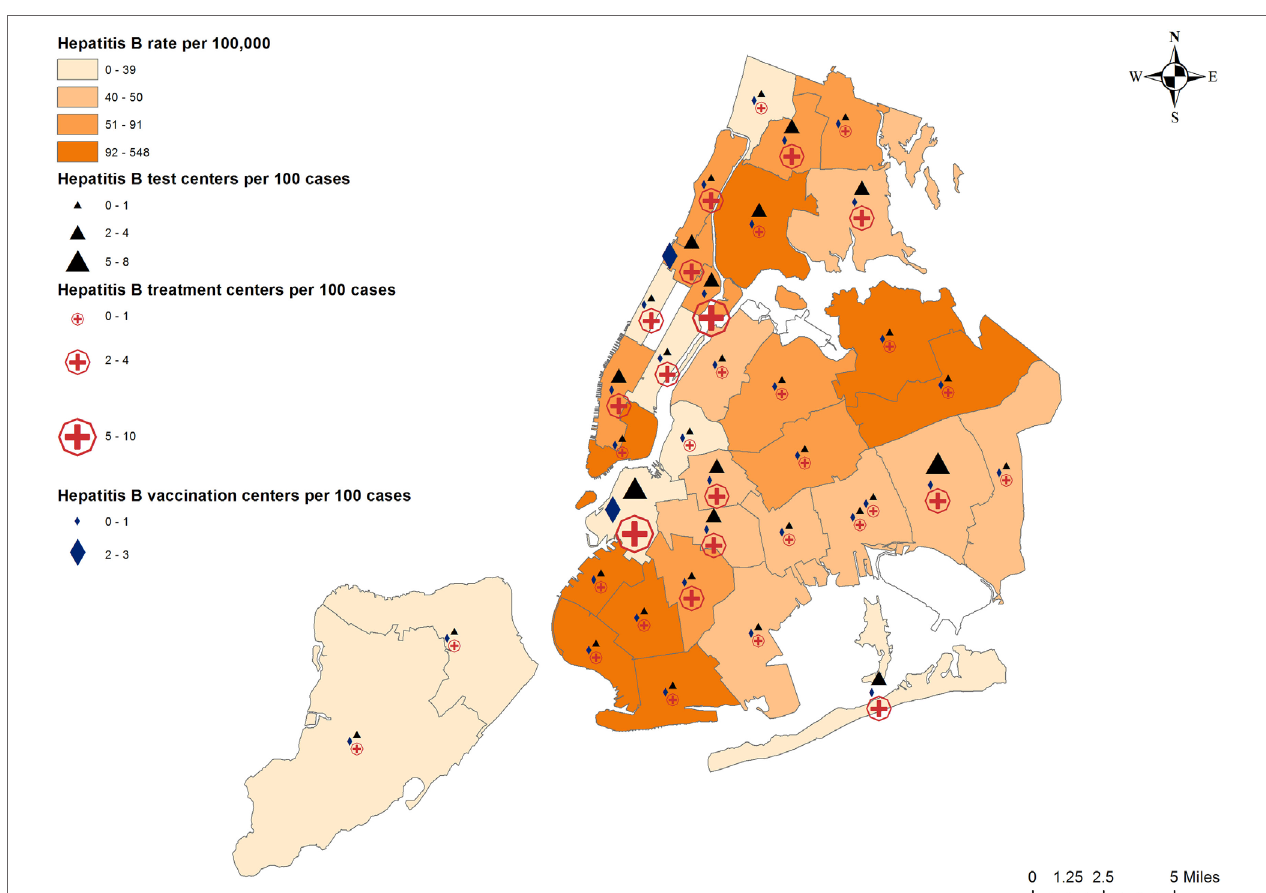
FigUre 2 | Prevalence of hepatitis B and availability of preventive